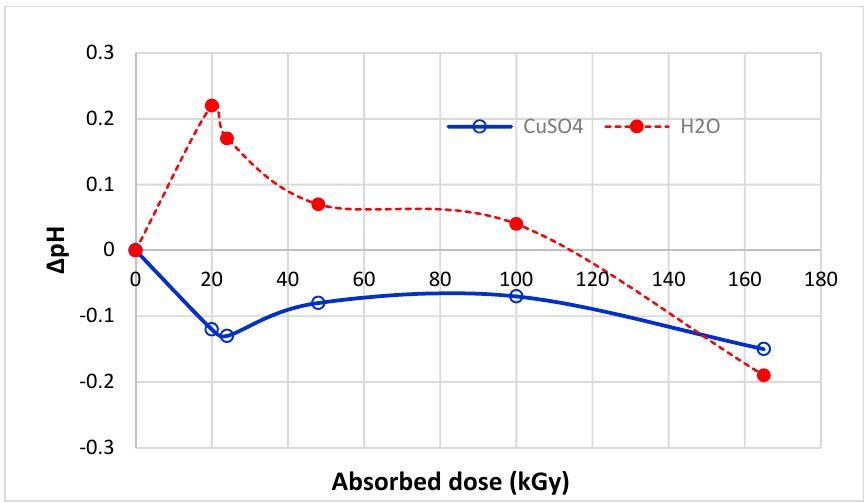
Figure 8. Development of pH-differences in baths containing wool with different absorbed dose immersed in deionized water or 100 mmol.dm − 3 CuSO 4 against wool with 0 kGy.